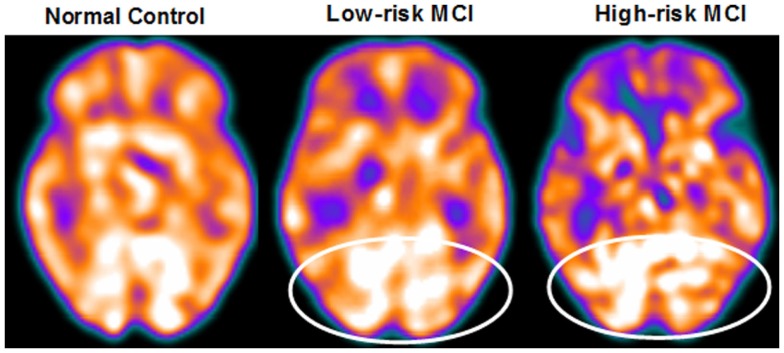
SPECT visual rating. The output shows a SPECT visual inspection of glucose uptake metabolism: the white square denotes an area of mild-to-moderate temporo-parietal hypometabolism in one of the 14 at low risk and in one of the 13 at high risk MCI patient respect to one of the 17 enrolled controls. The results are representative of the entire groups.